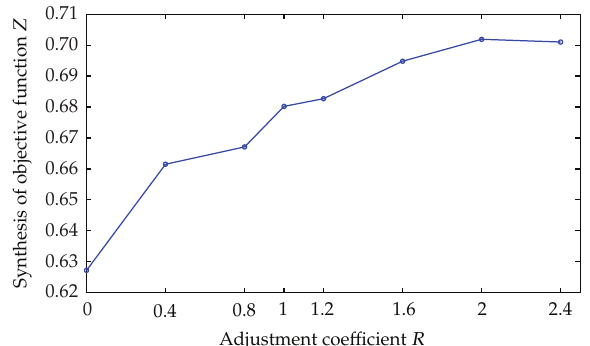
Figure 4: Curve of Z changed with R when operation time is